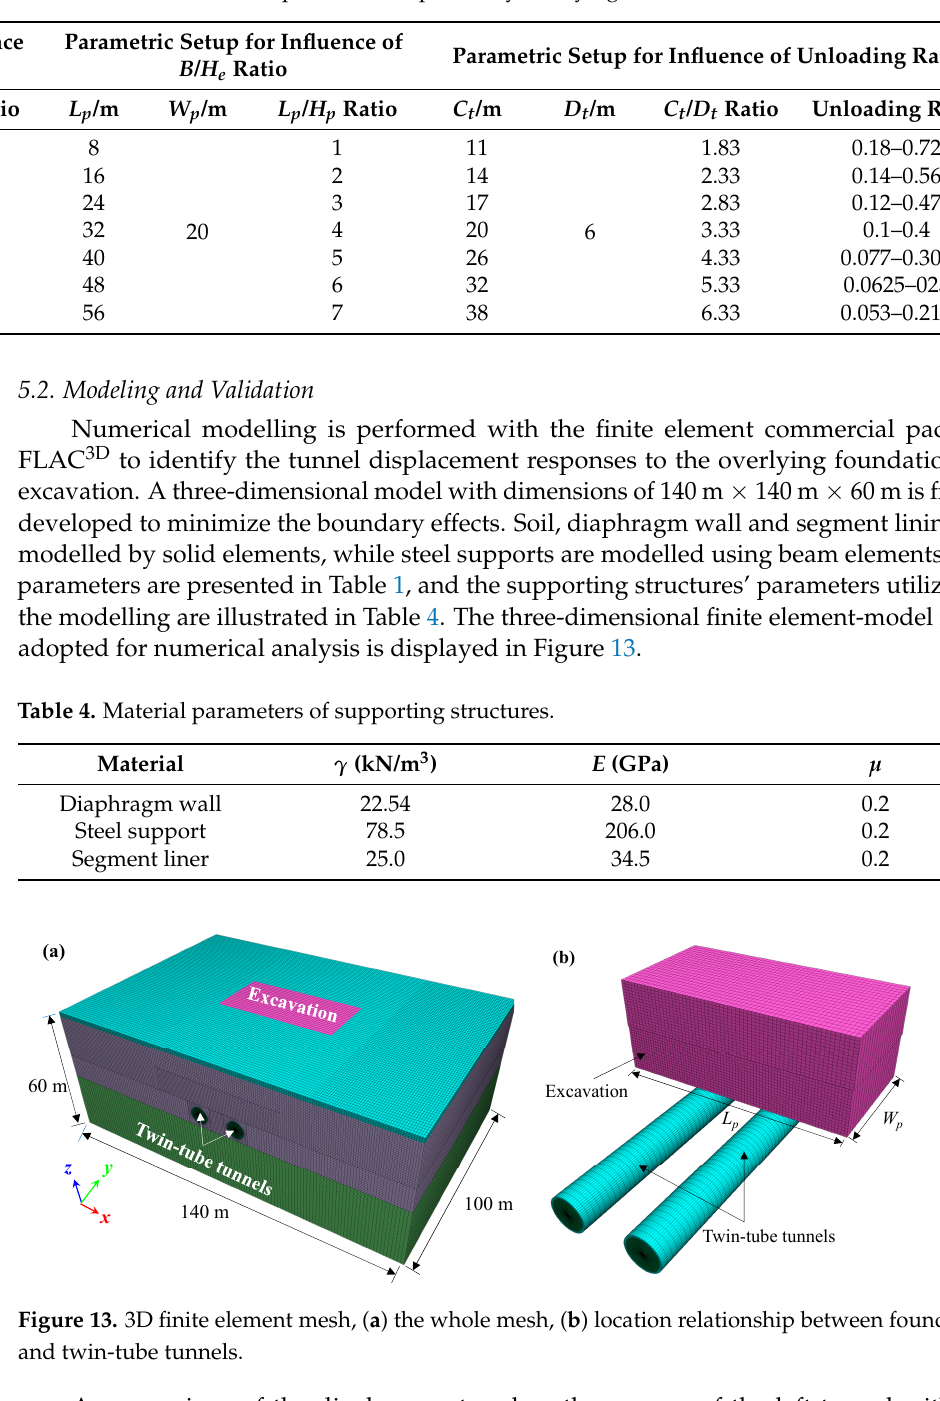
Table 3. Parameters considered on tunnel displacement responses by overlying foundation excavation.